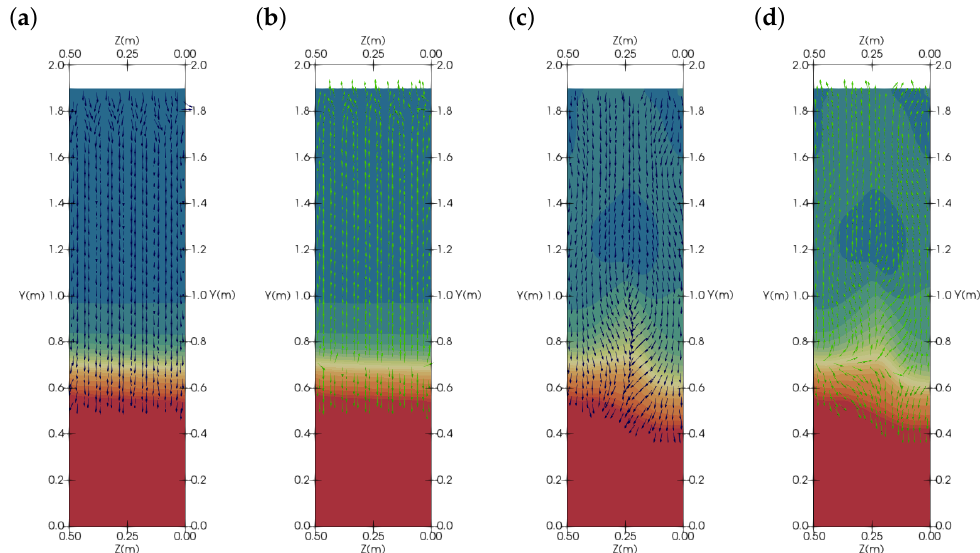
Figure 21. Water velocity (blue arrows) and air velocity (green arrows) and wetting-front within the fracture of models TUFF3D and TUFF3D-VA. ( a ) water velocity, constant aperture, ( b ) air velocity, constant aperture, ( c ) water velocity, varied aperture and ( d ) air velocity, varied